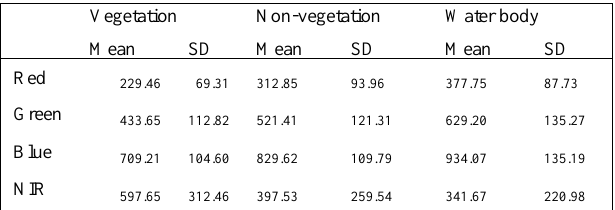
Table 3. Summary of descriptive statistics of DN values of